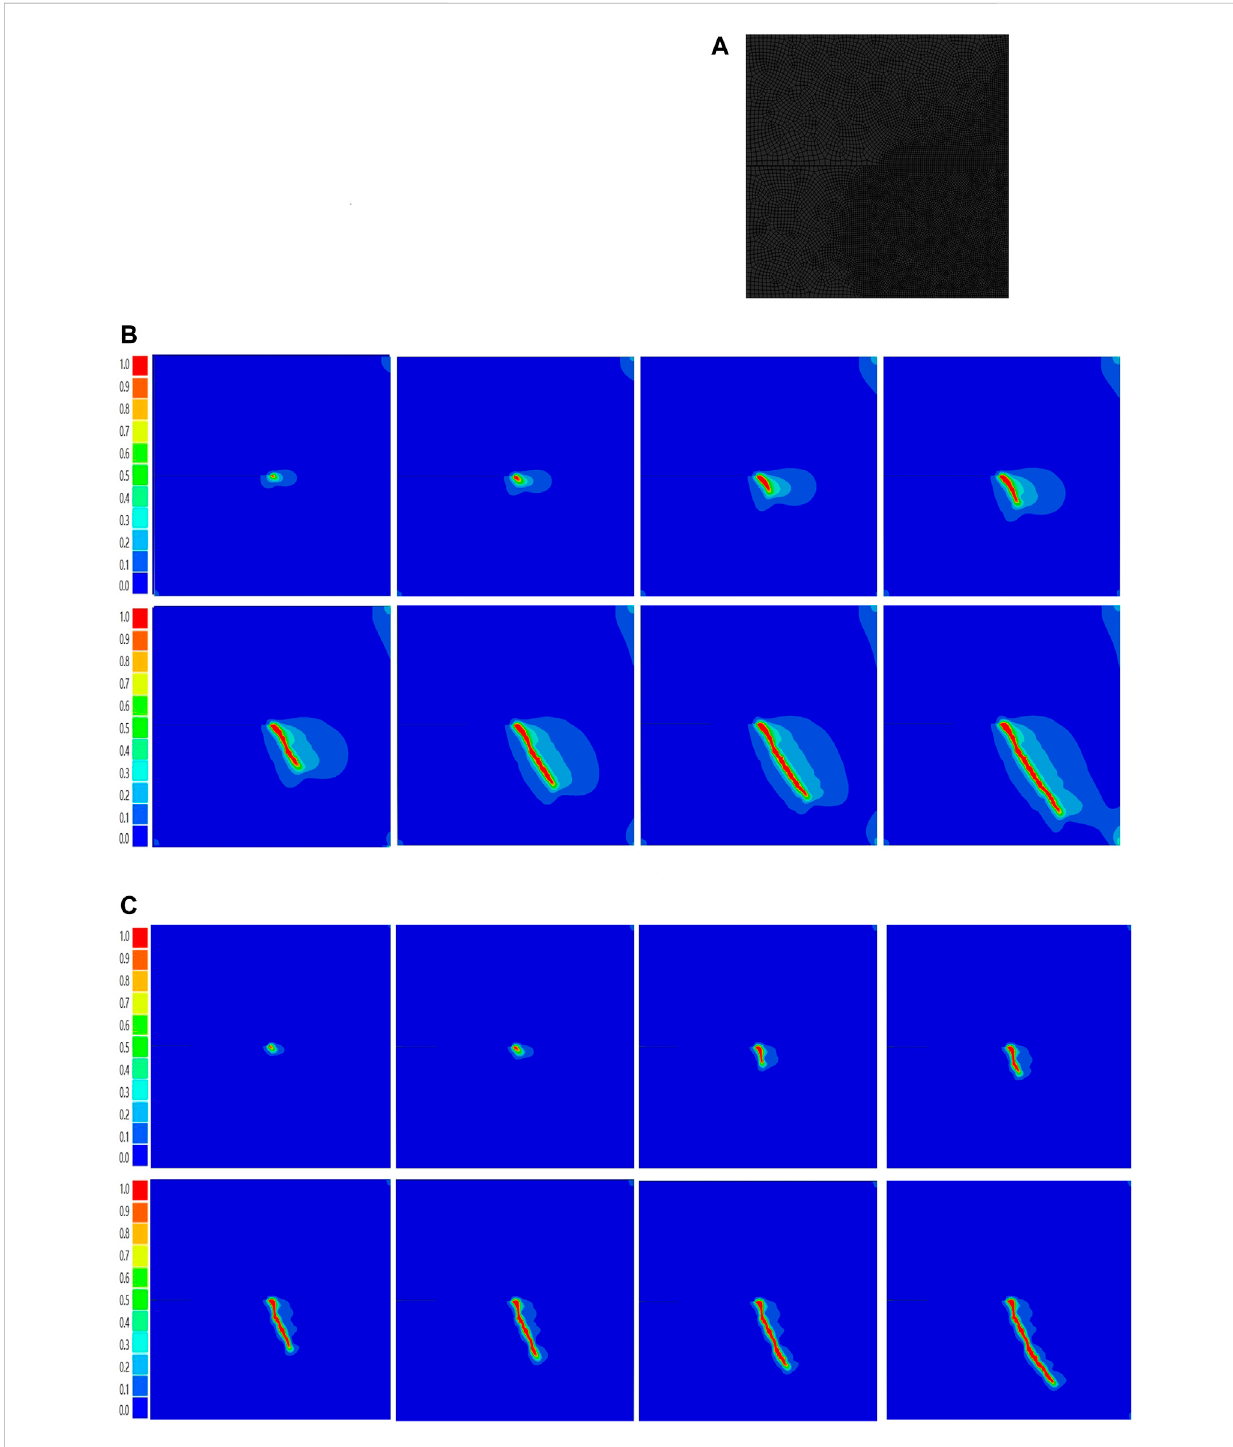
propagation under complex stress-displacement boundary conditions, which enables it to fi t large-scale rock models while maintaining crack tracking precision. Consequently, further numerical simulations will be conducted to comprehensively investigate, analyze and compare the performance of our proposed